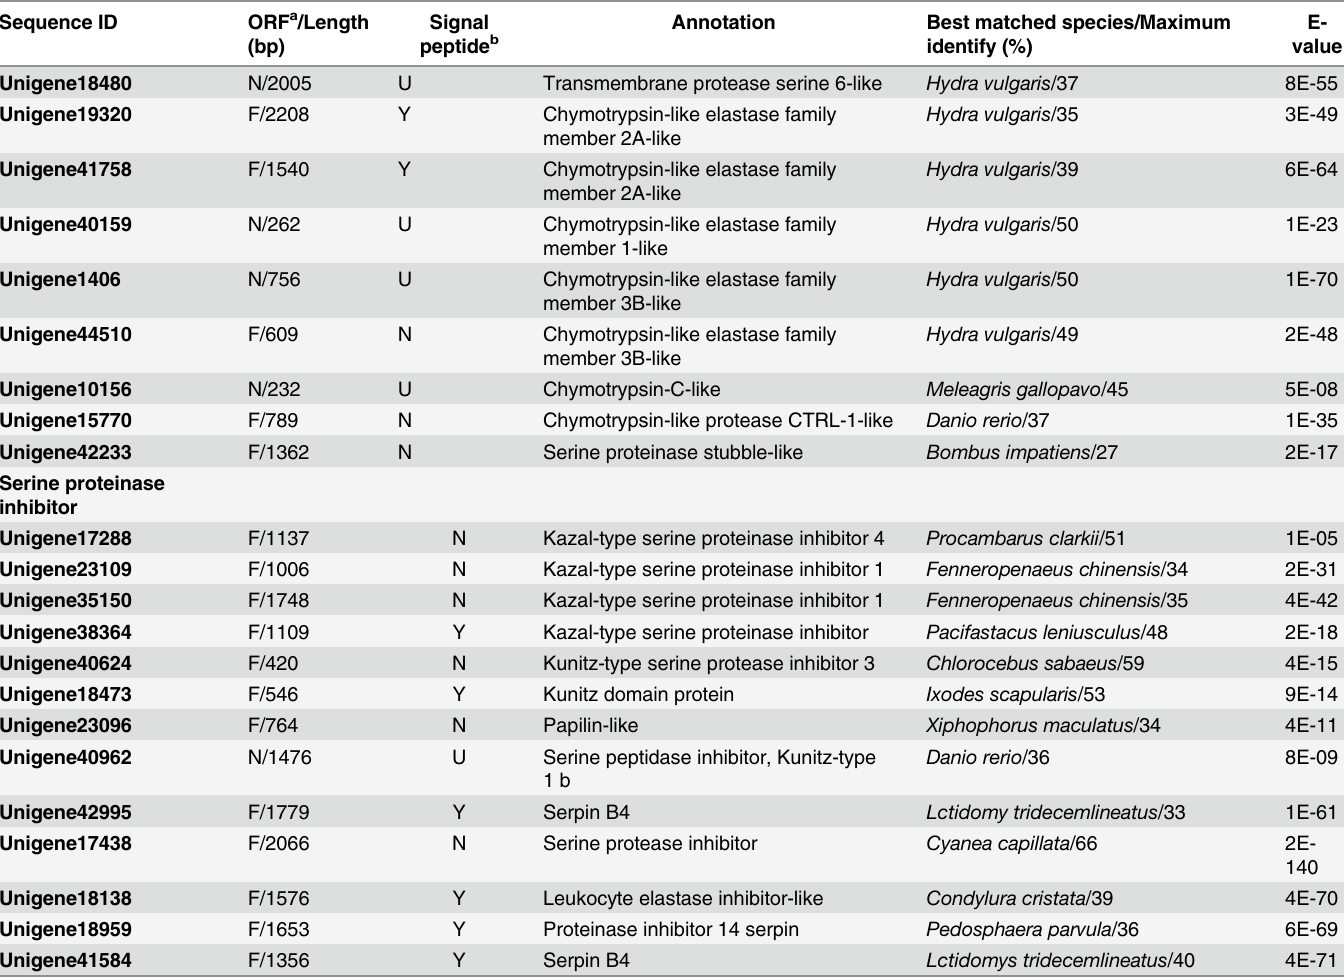
a Full-length and not full-length open reading frames (ORFs) are indicated by “ F ” and “ N ” , respectively. b Transcripts with or without a signal peptide are indicated by “ Y ” and “ N ” , respectively, whereas transcripts in which the presence of a signal peptide was unclear are indicated by “ U ”